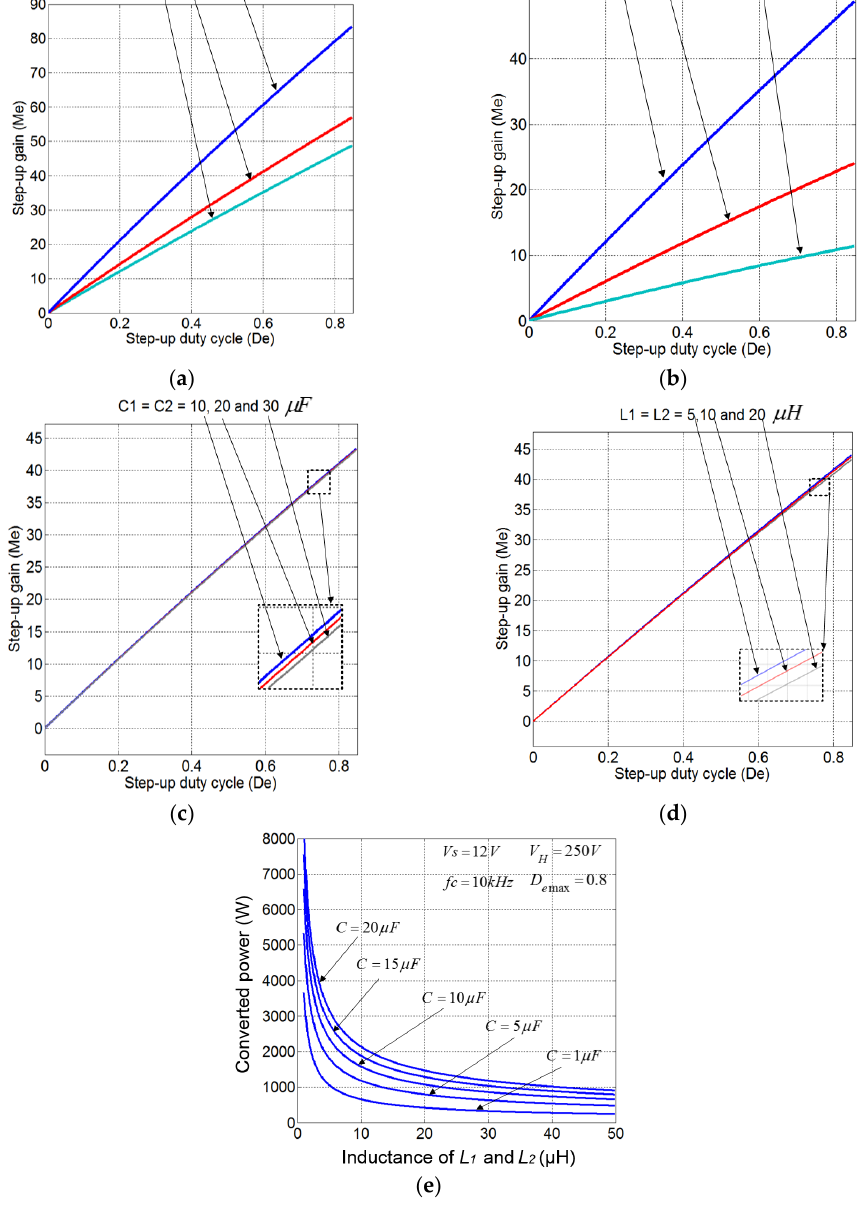
Figure 3. ( a ) Evolution of M e versus D e with resistances of different loads. ( b ) Evolution of M e versus D e with different Z-source resistances. ( c ) Evolution of M e varying D e , with various values of C of the Z-source and different resistances of load. ( d ) Evolution of M e varying D e , with various values of L of the Z-source and different resistances of load. ( e ) Converted power into a function of the parameters L and C of the Z-source.